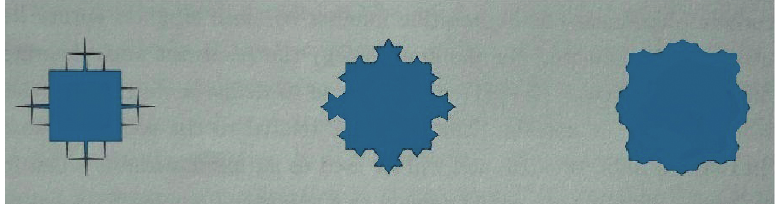
Figure 3: Pre-fractal Koch Islands Ω 2 α with α = 2.1, α = 3 and α = 3.75, respectively.